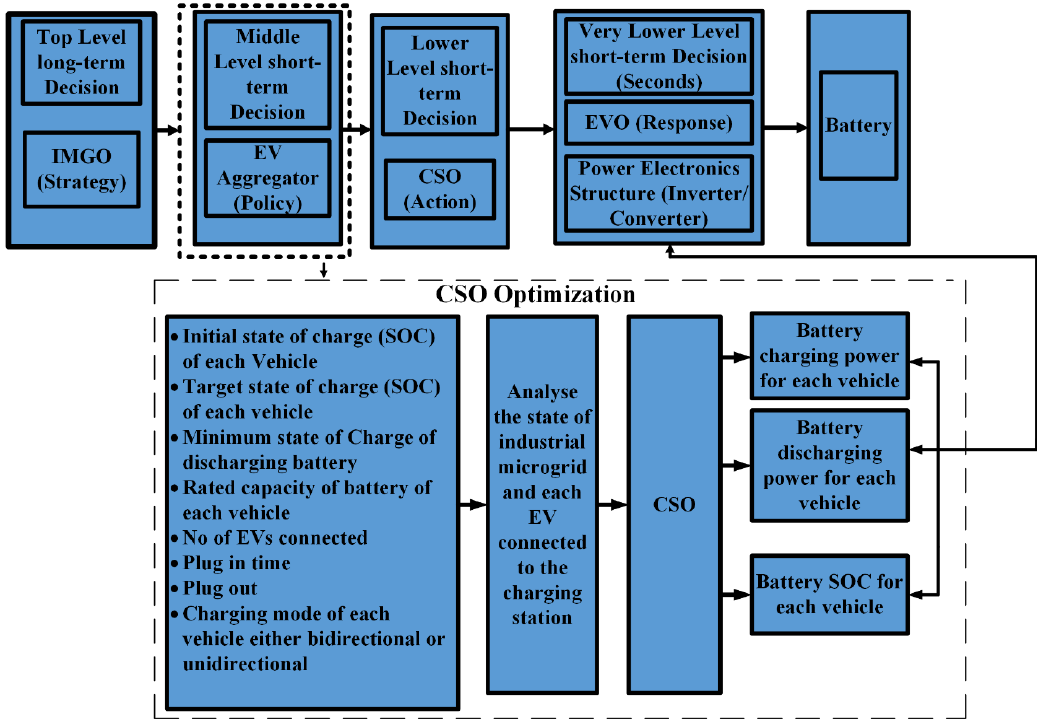
Figure 2. Charging station operator optimization.